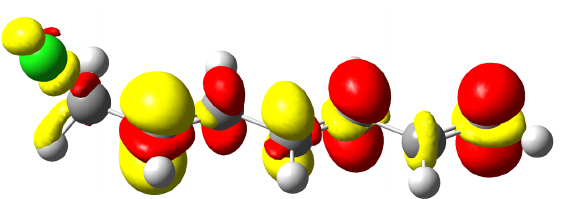
Figure 10. Polarisation electron density in 1-chloromethyl-hexatriene δρ > 0 colored in red while δρ < 0 colored in yellow. Isovalue of 1.0 × 10 − 4 a . u